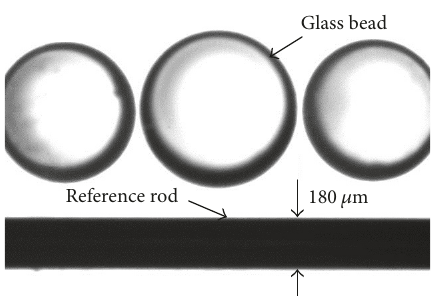
Figure 2: Micrograph of a glass bead to determine the particle model for the simulation.